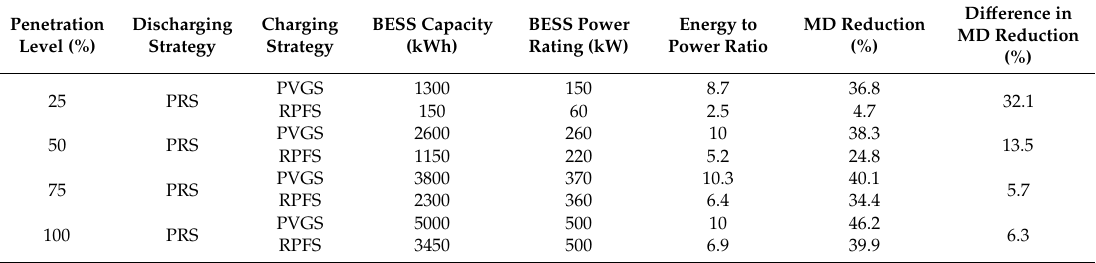
Table 5. Comparison of the results.